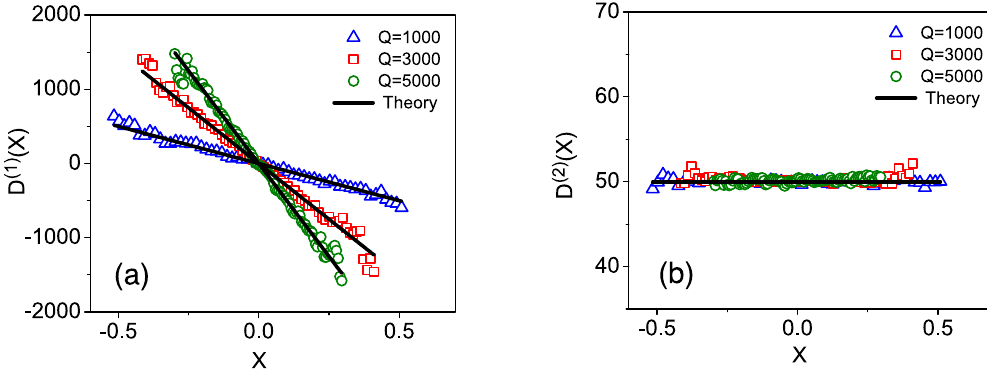
Figure 3. Reconstruction of a linear Langevin process. The KM-based estimated drift ( a ) and diffusion ( b ) terms for the synthetic time series with Q = 1000, 3000, and 5000, and D 0 = 50. The solid lines in ( a , b ) show the considered values of Q s and D 0 . The analyzed time series consists of 10 7 data points with a sampling interval of Δ t = 10 − 6 . For Q = 5000 we averaged the results for the diffusion coefficients over 10 realisation of time series.